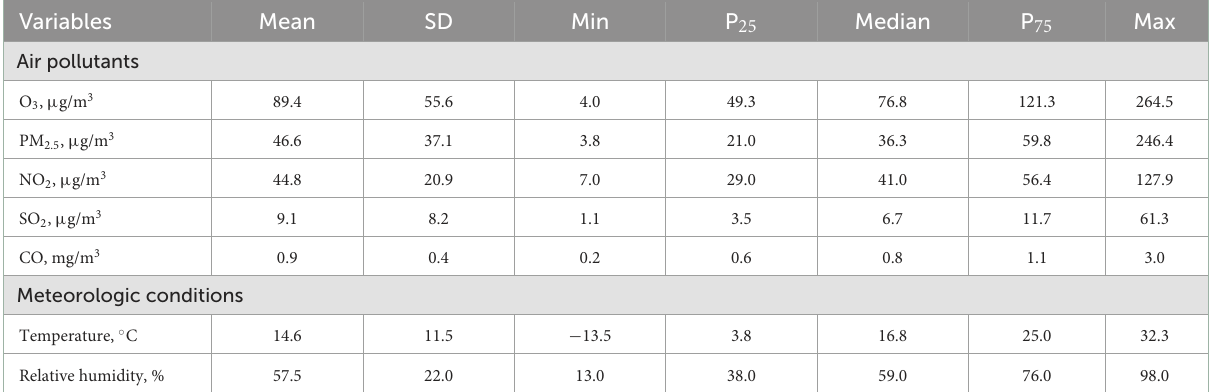
TABLE 2 Descriptive statistics of air pollutants and meteorological conditions in 18 Chinese cities,